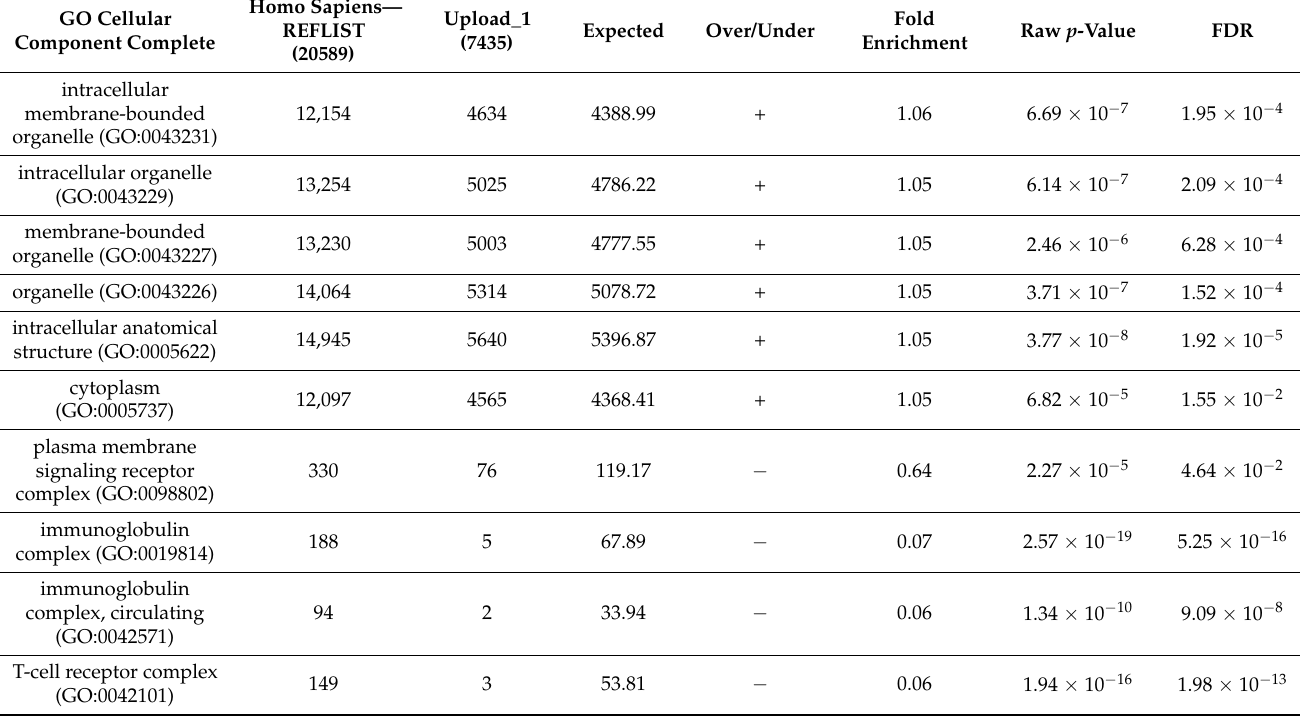
Table 2. GO cellular components in 122 CRC patients with CNAs in HDAC2 , B2M , and CIITA .